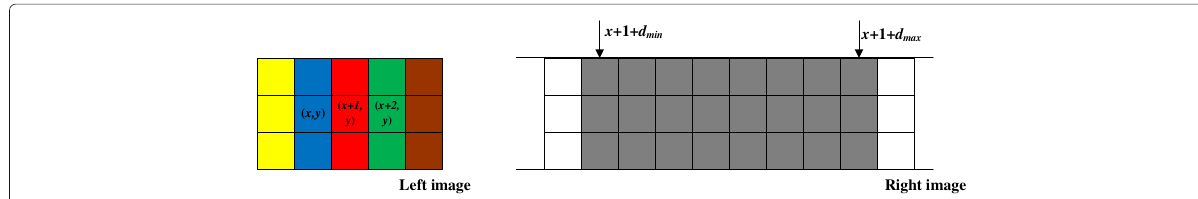
Fig. 2 An example showing the 3 × 3 support windows ( w = 1) of three consecutive pixels ( x , y ) , ( x + 1, y ) and ( x + 2, y ) in the left image. These three support windows share a common column (colored with red). For a given support window in the left image, a series of d -shifted support windows in the right image are matched against. The counterparts of this red column in these d -shifted support windows occupy an identical region of pixels in the right image (shaded with